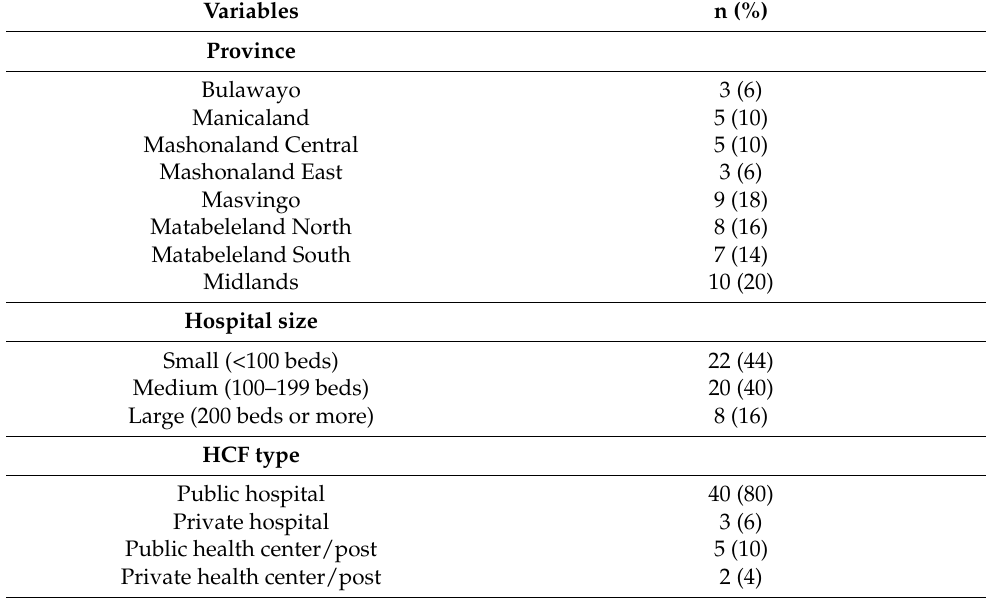
Table 1. Key characteristics of 50 health care